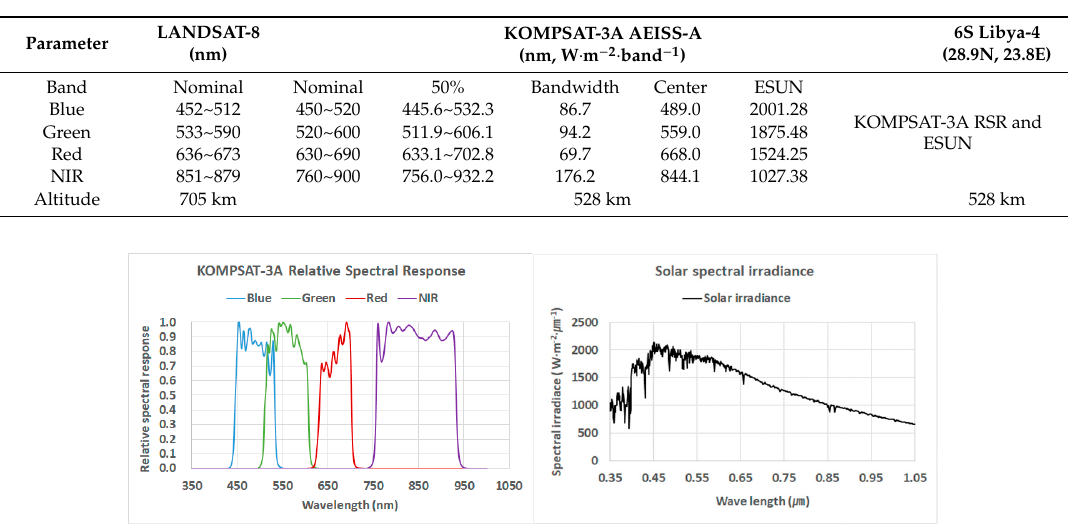
Figure 2. The relative spectral response (RSR) of Korea Multi-Purpose Satellite-3A (KOMPSAT-3A) and the solar spectral irradiance. Table 2. KOMPSAT-3A characteristics and the Second Simulation of Satellite Signal in the Solar Spectrum (6S).